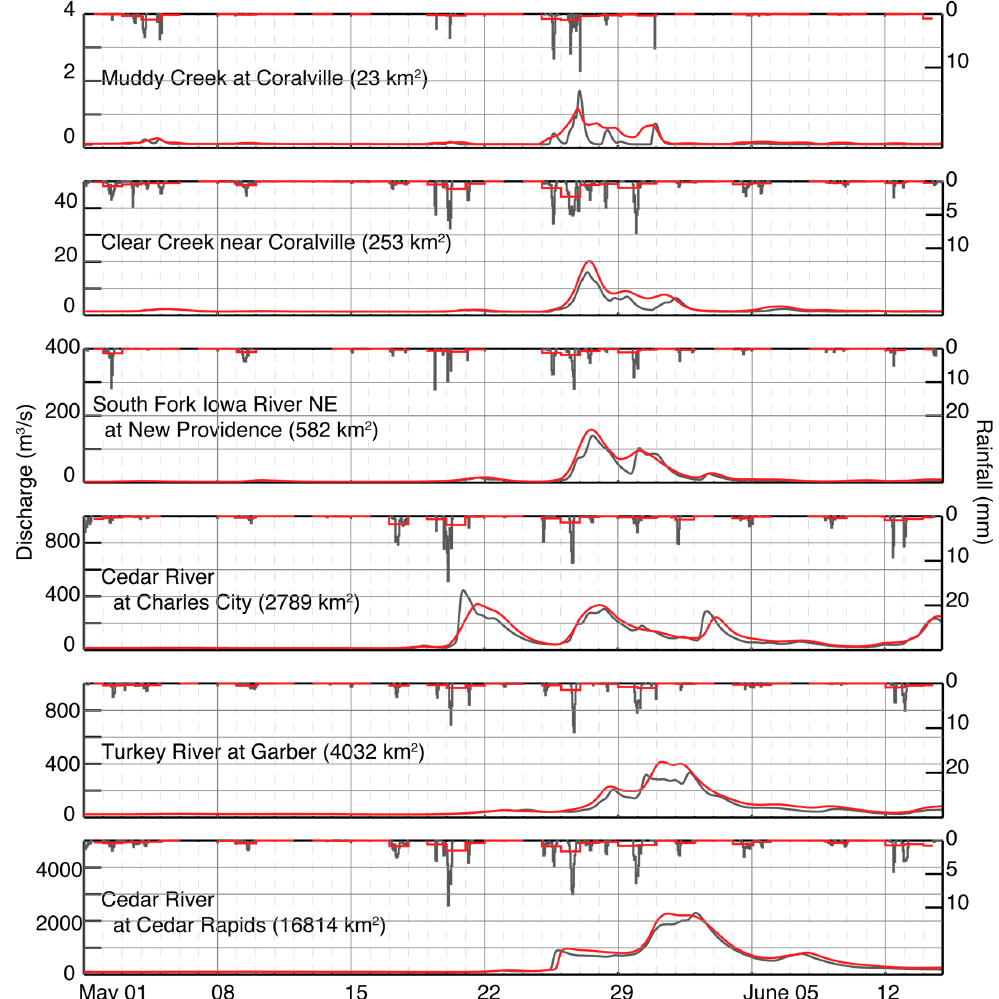
Figure 3. Comparison of hydrographs obtained using hourly fine-resolution radar rainfall (gray line) and daily coarse-resolution rainfall (red line). The dates correspond to the spring of 2013.